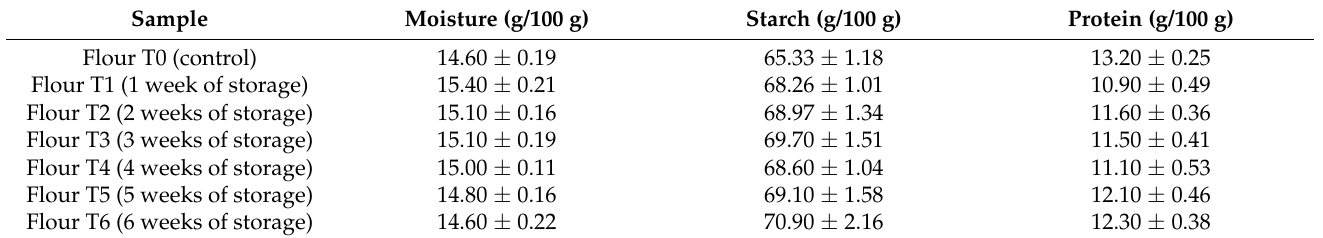
Table 1. Results of flours characterization and analyses (based on dry weight). Results are expressed as the mean of the three replicates ± SD.